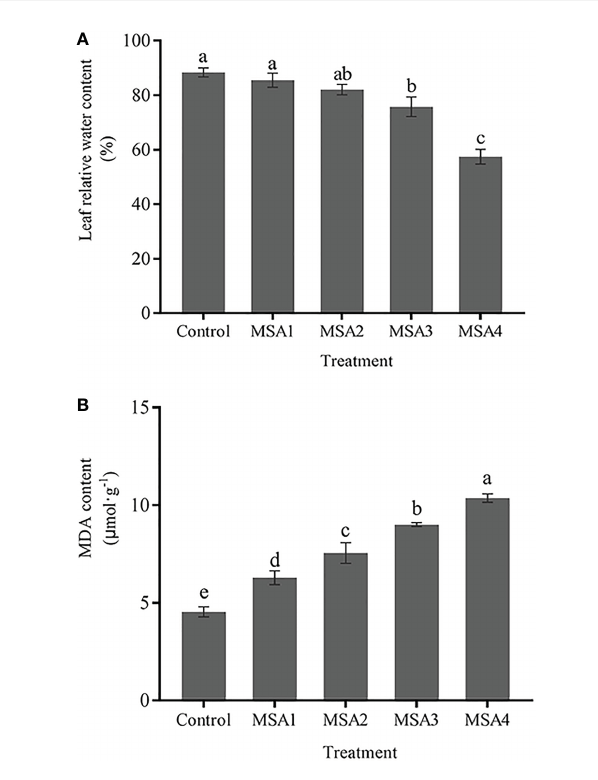
FIGURE 1 Changes in the leaf relative water content (A) and MDA content (B) of Trollius chinensis under saline-alkaline stress. Control, 0 Mm; MSA1, 40 mM; MSA2, 80 mM; MSA3, 120 mM; MSA4, 160 mM. Values are the means ± standard errors (SEs). Means followed by different letters indicate signi fi cantly difference between treatments at p < 0.05 according to Duncan ’ s test. The same as below.